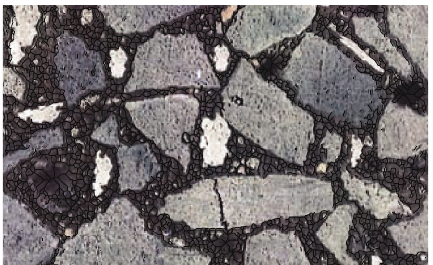
Figure 2: Composition A.